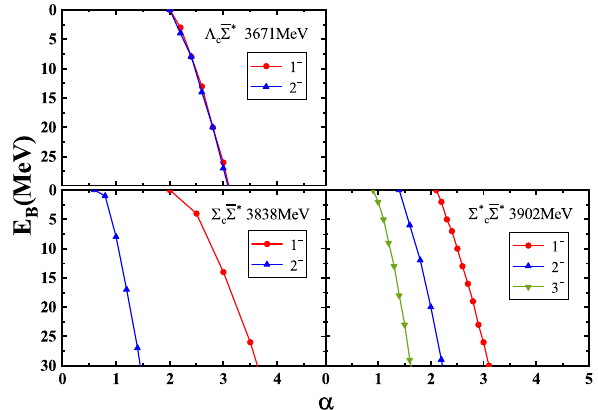
Fig. 5 Binding energies of isovector bound states from the charmed- antistrange interactions with the variation of α in single-channel calcu-